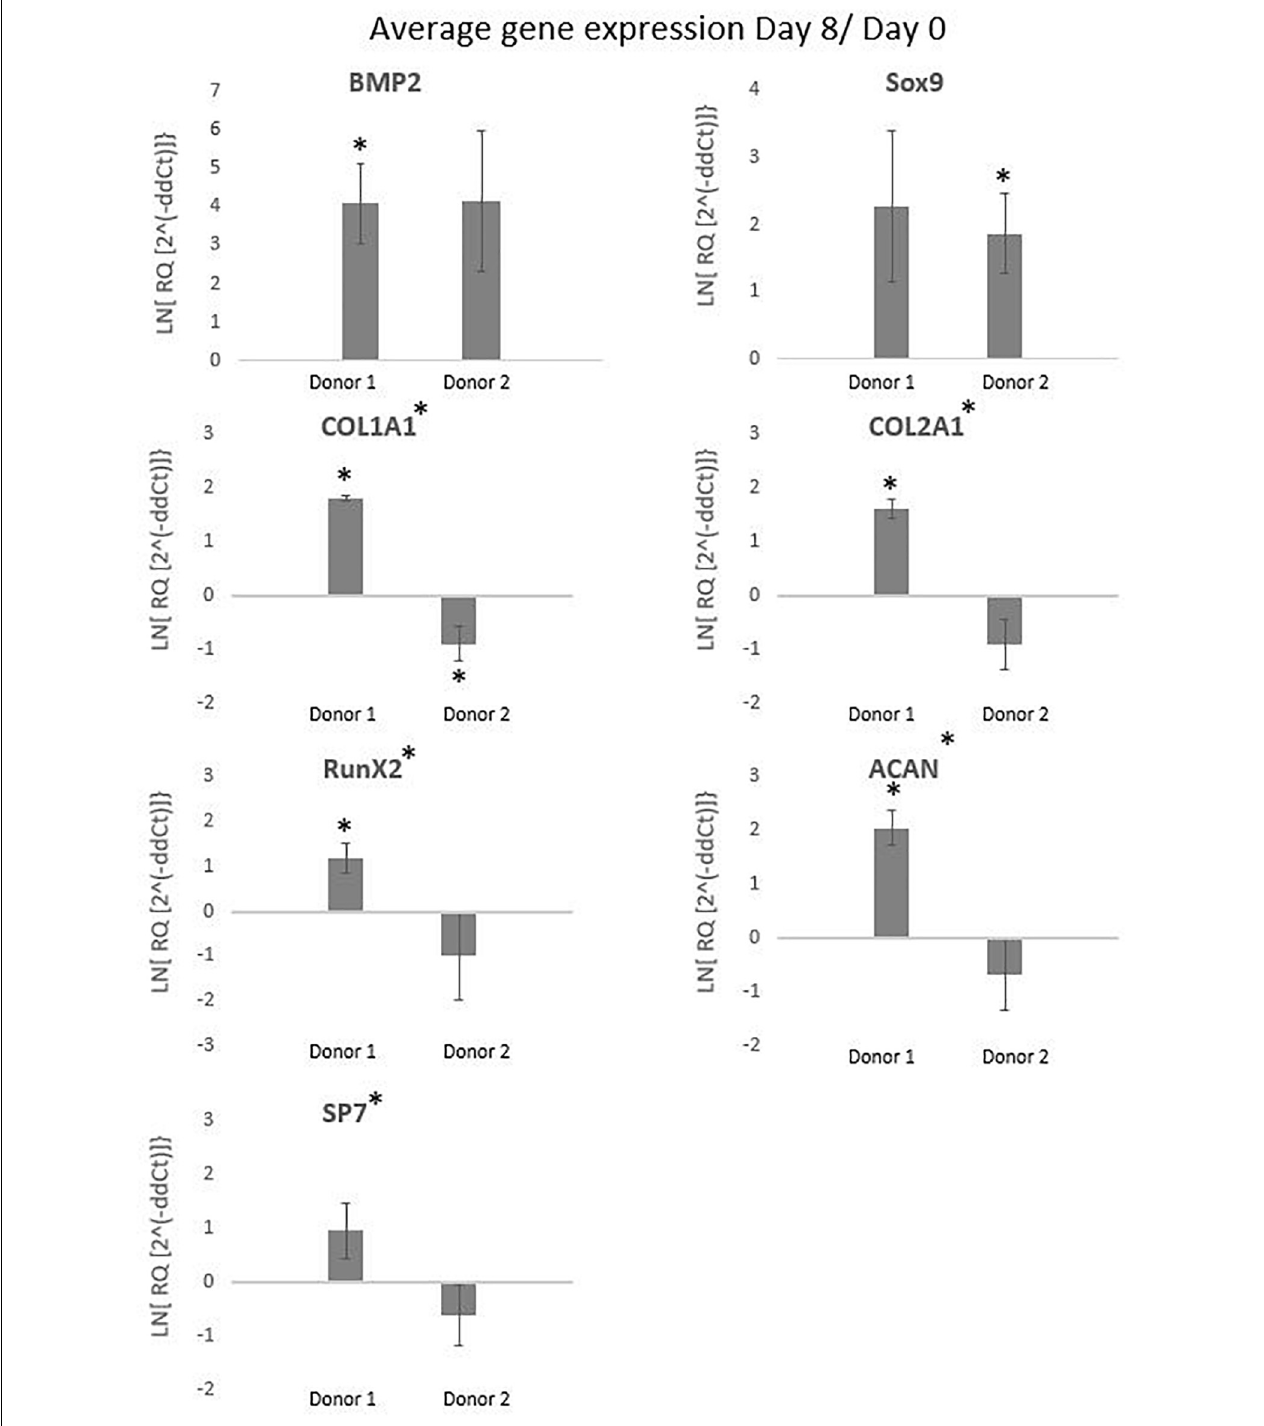
FIGURE 10 | The graphs represent the average gene expressions from hPDCs cultured on Star-Plus in triplicate spinner flasks for two different donors after 8 days compared to day 0. The analyzed genes were bone morphogenetic protein 2 (BMP2), collagen I (COL1A1), RUNX family transcription factor 2 (Runx2), osterix (SP7), 573 sex determining region box 9 (Sox9), collagen 2 (COL2A1), and aggrecan (ACAN). The test uses a significance level of 95%, where ( ∗ ) placed besides the gene name indicates a significant difference between donor 1 and 2 and ( ∗ ) placed at the value of a donor indicates the significant difference between that donor on day 8 compared to day